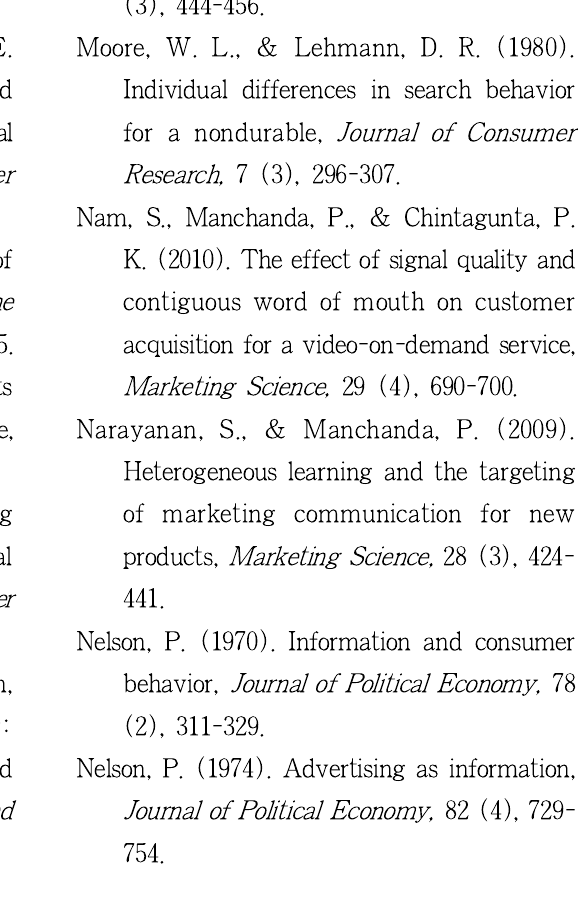
The Effect of Rating Dispersion on Purchase of Experience Goods based on the Korean Movie Box Office Data